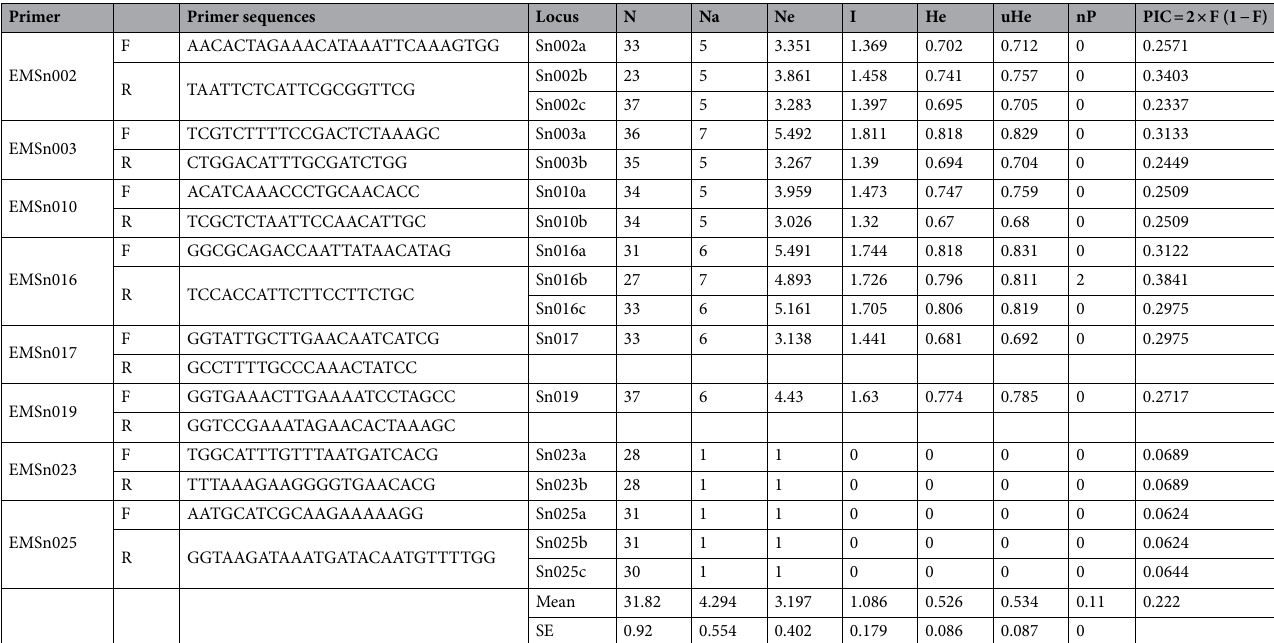
Table 1. Genetic diversity estimates for Sambucus wightiana at seventeen loci and averaged over all sub- populations. N; Sample size, Na; No. of Alleles, Ne; No. of Effective Alleles, I; Information Index, He; Expected Heterozygosity, uHe; Unbiased Expected Heterozygosity, nP; Number of Private Alleles and PIC; Polymorphic Information